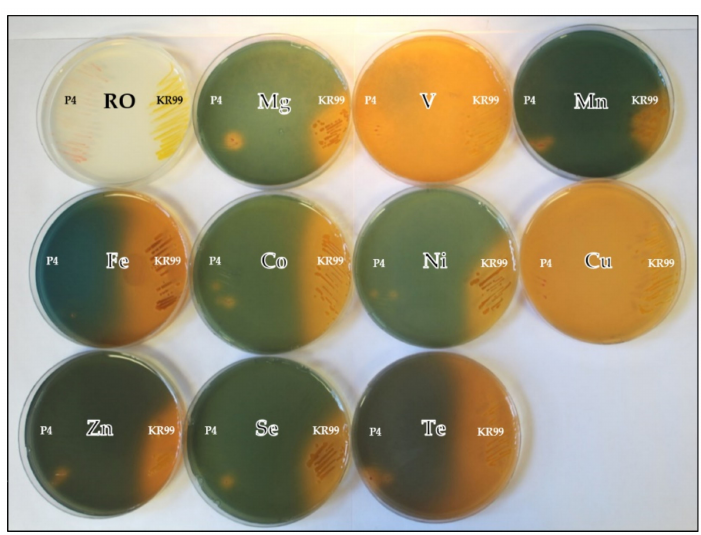
Figure A2. Variant metal(loid) CAS assay after 5 days’ growth for strains P4 and KR99. Growth on RO without CAS was compared to those CAS plates supplemented with Mg, V, Mn, Fe, Co, Ni, Cu, Zn, Se, or